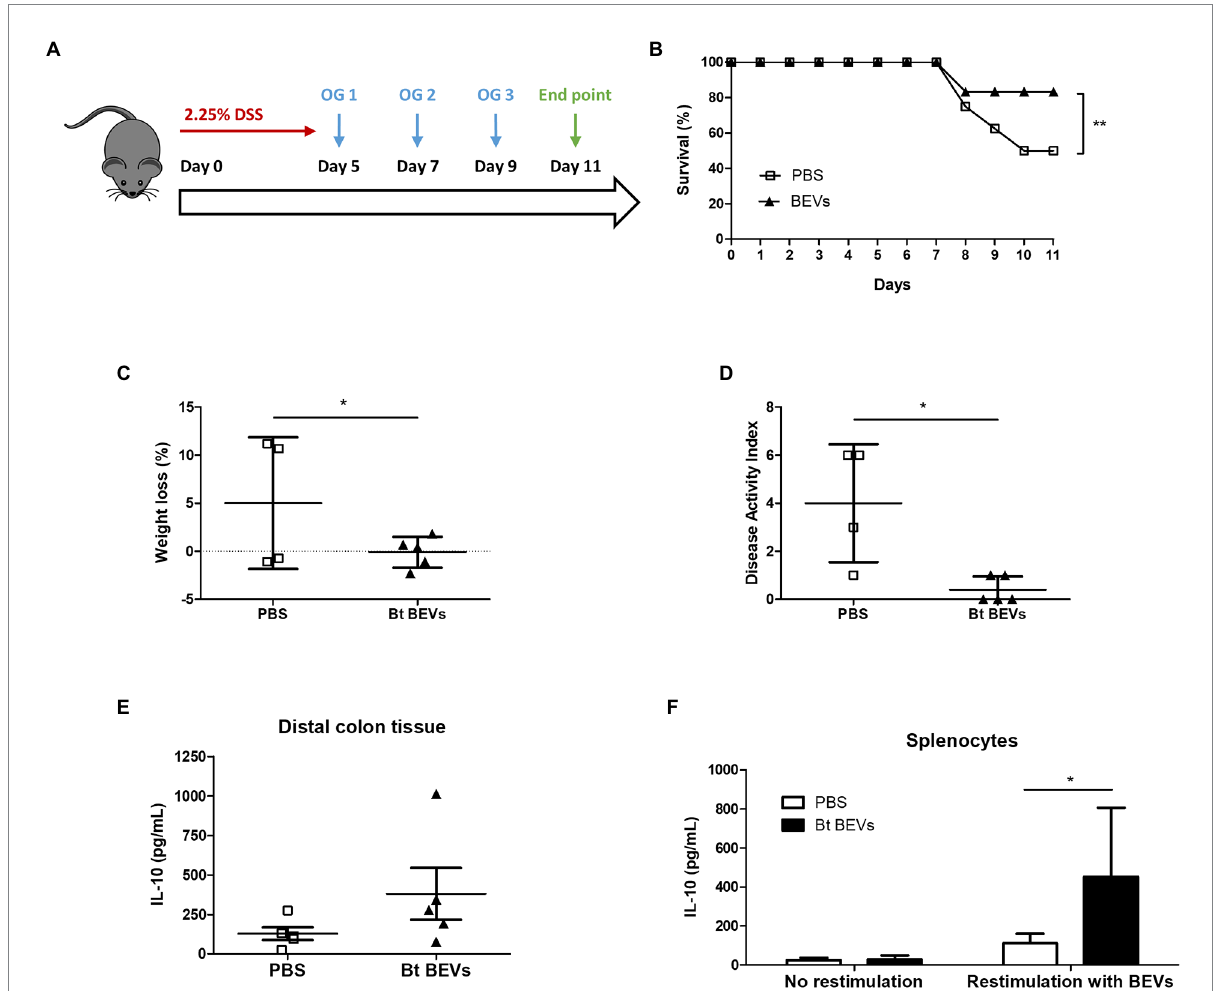
FIGURE 1 Bt BEVs ameliorate DSS-induced colitis in mice. (A) Mice were provided with drinking water containing 2.25% DSS (w/v) for 5 days. On days 5, 7, and 9 mice were orally administered with either PBS or Bt BEVs (100 μ l at 10 11 BEV/ml). (B) Survival rates. (C) Percent weight loss at day 11. (D) Disease Activity Index (DAI) at day 11. (E) IL-10 production in distal colon tissue. (F) IL-10 production by splenocytes cultured in complete media alone or in media containing Bt BEVs. Graphs depict mean ± SD values. * p < 0.05, ** p <